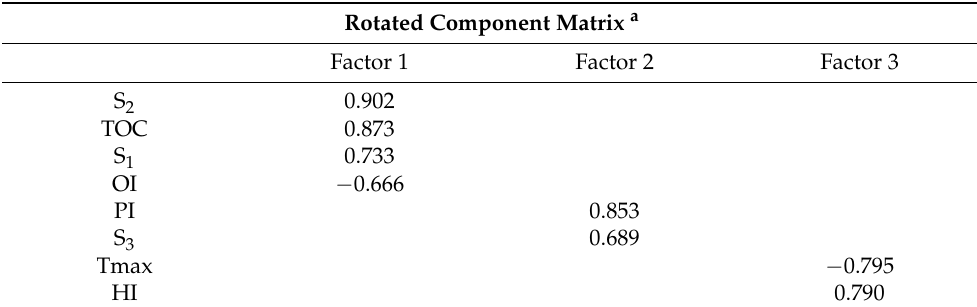
Figure 6. Graphical modeling of Spearman correlation coefficient for the studied samples of Mont- ney Formation. Table 3. PCA of the pyrolysis parameters for the studied samples of Montney Formation showing the extraction of three